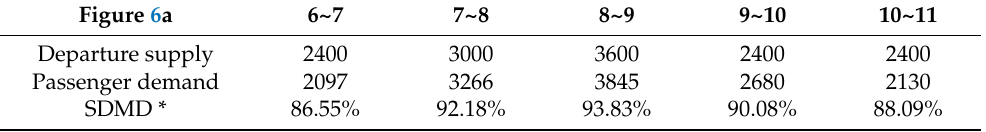
Figure 7. Supply and demand matching diagram under scenario 2. ( a ) Supply and demand matching diagram of multi-cycle train timetable. ( b ) Supply and demand matching diagram of single-cycle train timetable. Table 8. Details of supply and demand matching degree of multi-cycle timetable in scenario 2. Figure 6a